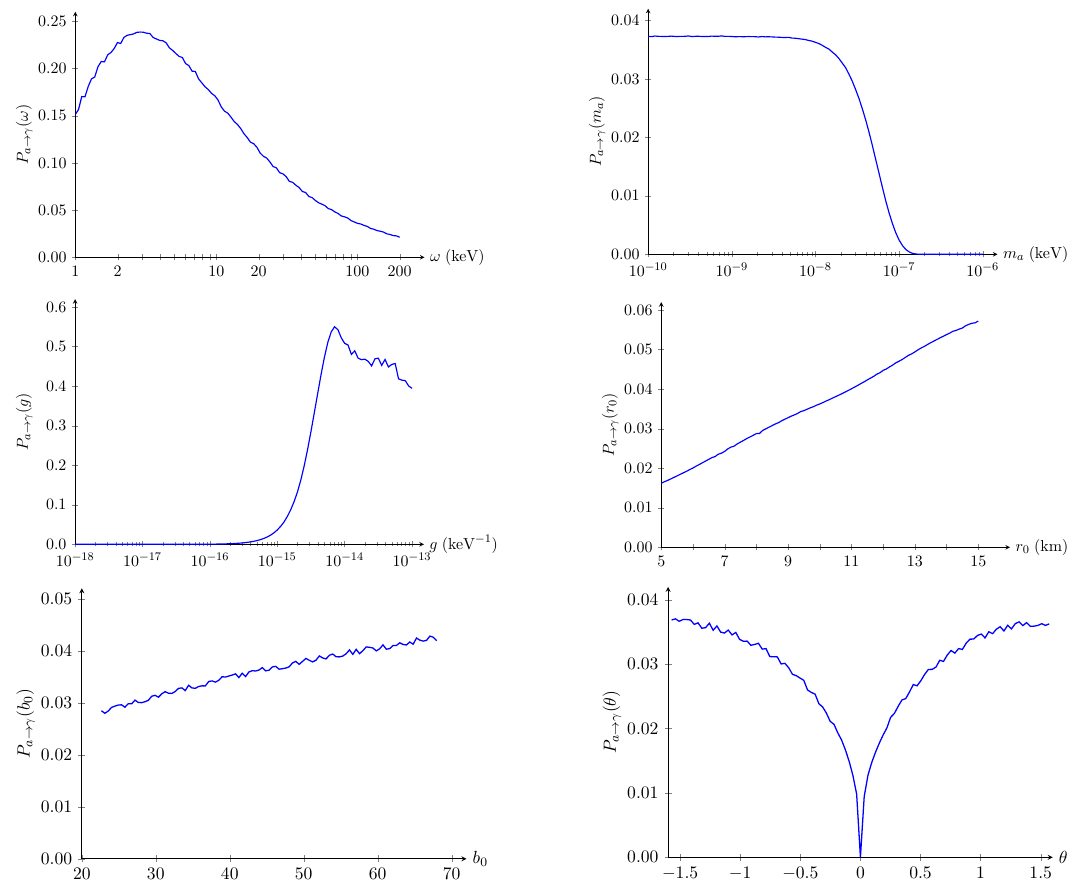
Figure 2 . ALP-to-photon conversion probability in function of the ALP and magnetar parameters for the benchmark point ! = 100 keV, m a = 10 (cid:0) 8 keV, g = 10 (cid:0) 15 keV (cid:0) 1 , r 0 = 10 km, B 0 = 20 10 14 G and (cid:18) = (cid:25)= 2. Each panel shows the dependence of the conversion probability around (cid:2) the benchmark point for one of the ALP or magnetar